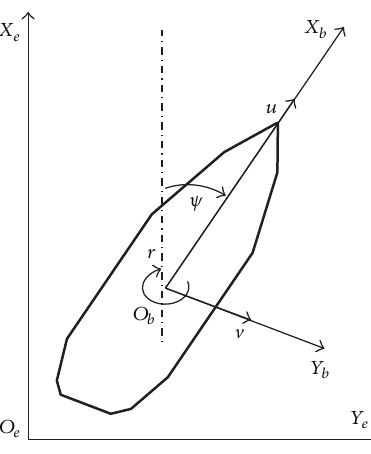
Figure 1: Relationship between Earth-fixed frame and Body-fixed